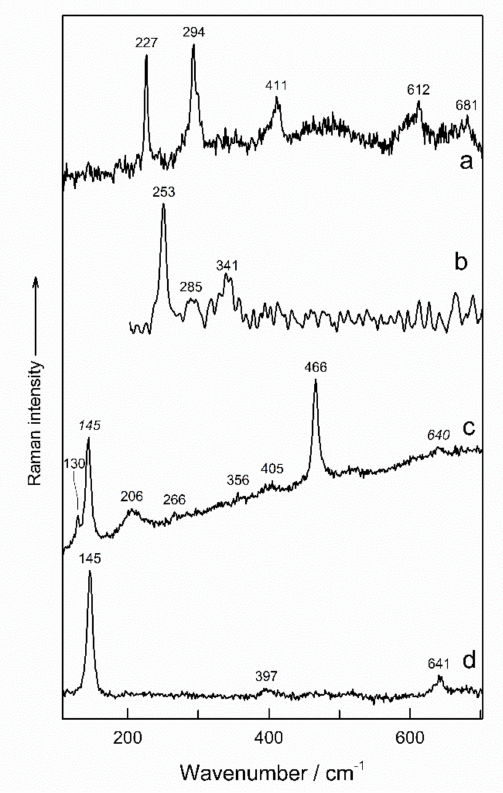
Figure 7. Sample My33: Raman spectra of ( a ) hematite; ( b ) vermilion; ( c ) quartz (the italic bands are from anatase); ( d ) anatase.